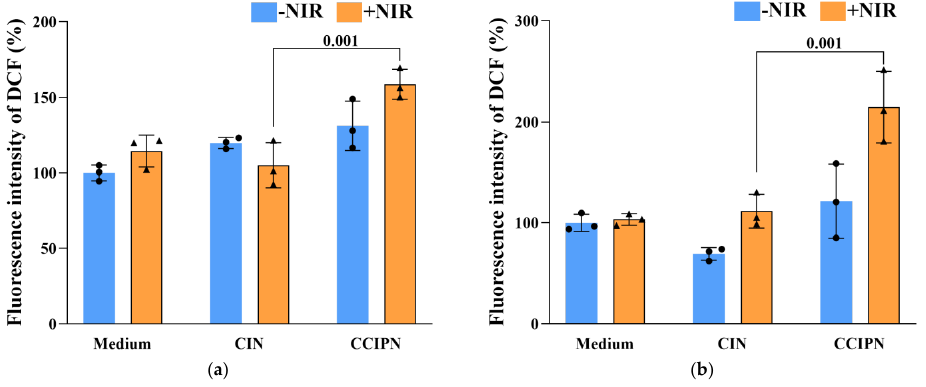
Figure 16. ( a ) Generation of intracellular reactive oxygen species indicated by DCF in DU145 cells treated with culture medium, CCIPN at 0.075 µg mL − 1 or CIN at 0.075 µg mL − 1 with/without NIR light irradiation. ( b ) Generation of intracellular reactive oxygen species indicated by DCF in PC3 cells treated with culture medium, CCIPN at 0.15 µg mL − 1 or CIN at 0.15 µg mL − 1 with/without NIR light irradiation. Values are expressed as mean ± SD (n = 3). Each dot represents an independent experiment. The p values vs. indicated groups are presented.